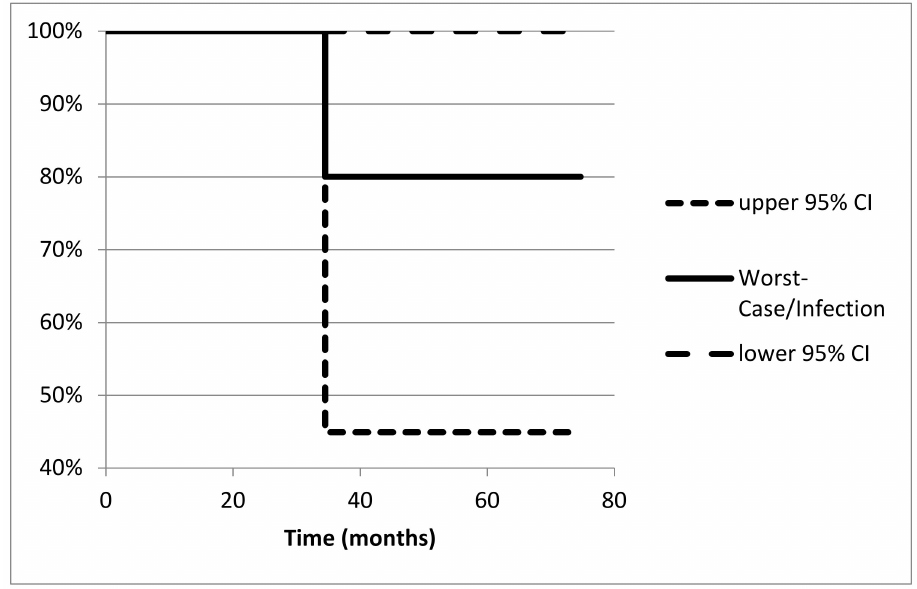
Figure 7. Survival of the implant: worst-case situation equates infection as failure reason ( n =